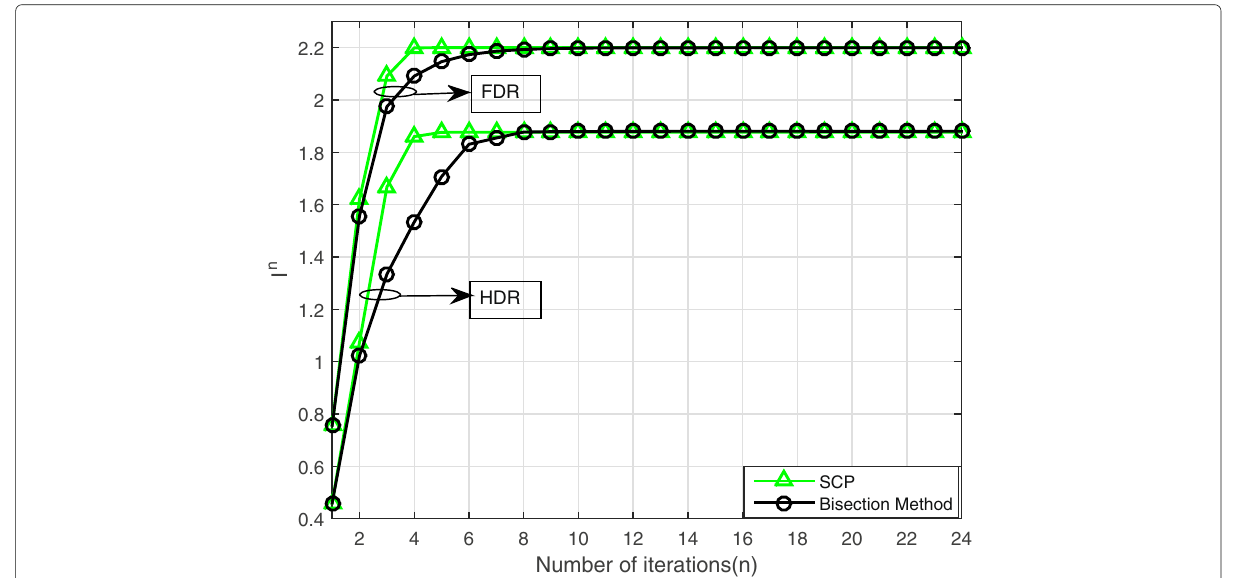
Fig. 8 Convergence of Algorithm 1 and Algorithm 2 for FDR/HDR systems with rate maximization: P max = 30 dB, m = 1, π 0 = 0.01, P 0 = P max , l = 0, u = 3, and N =